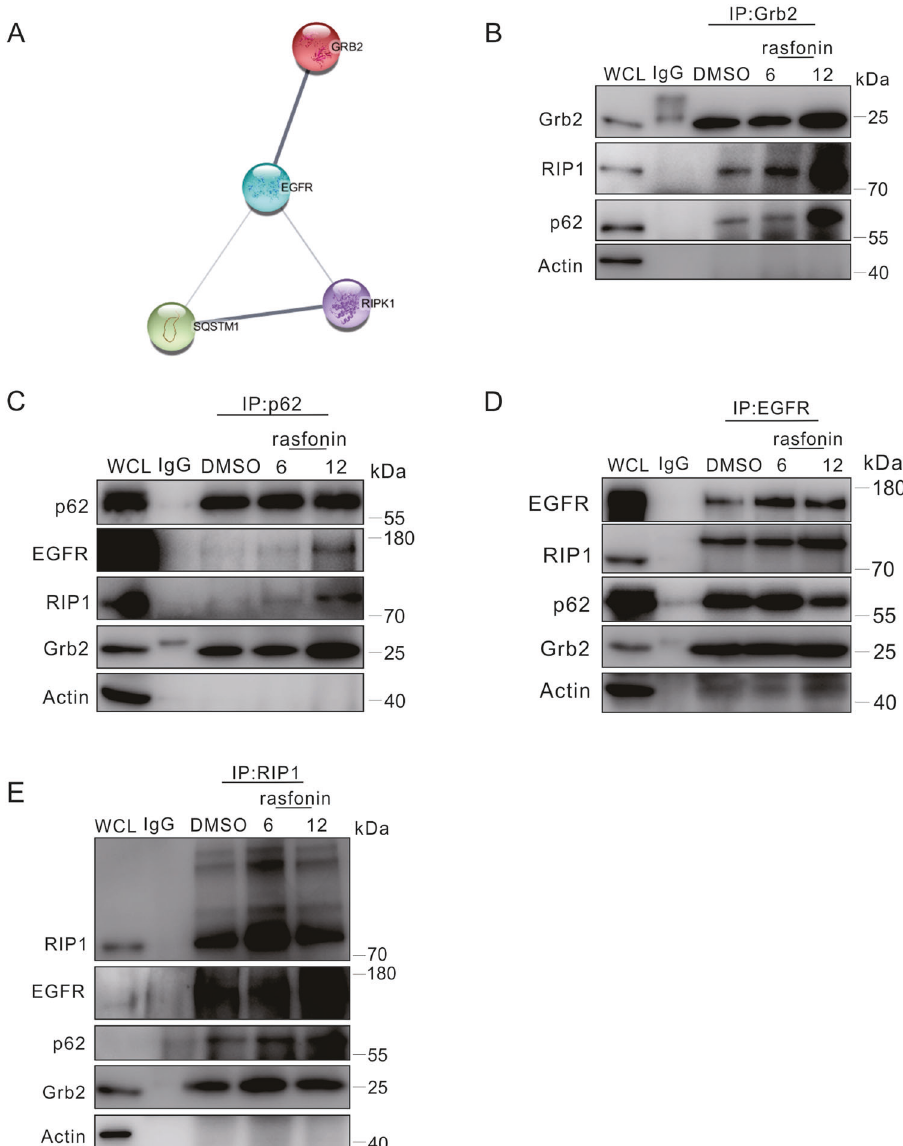
Fig. 4 Rasfonin enhanced the interaction of Grb2 with components of necrosomes. A The STRING network analysis of possible interactions among EGFR, Grb2, RIP1 and p62. B – E ACHN cells were exposed to rasfonin (6 or 12 μ M) for 6 h, and equal amounts of cell lysates were immunoprecipitated with the mouse monoclonal antibodies of Grb2, p62, EGFR, RIP1 or IgG. Immunoprecipitates were then immunoblotted for the indicated polyclonal (Grb2, p62 and EGFR) or monoclonal (RIP1) antibodies. Similar experiments were repeated